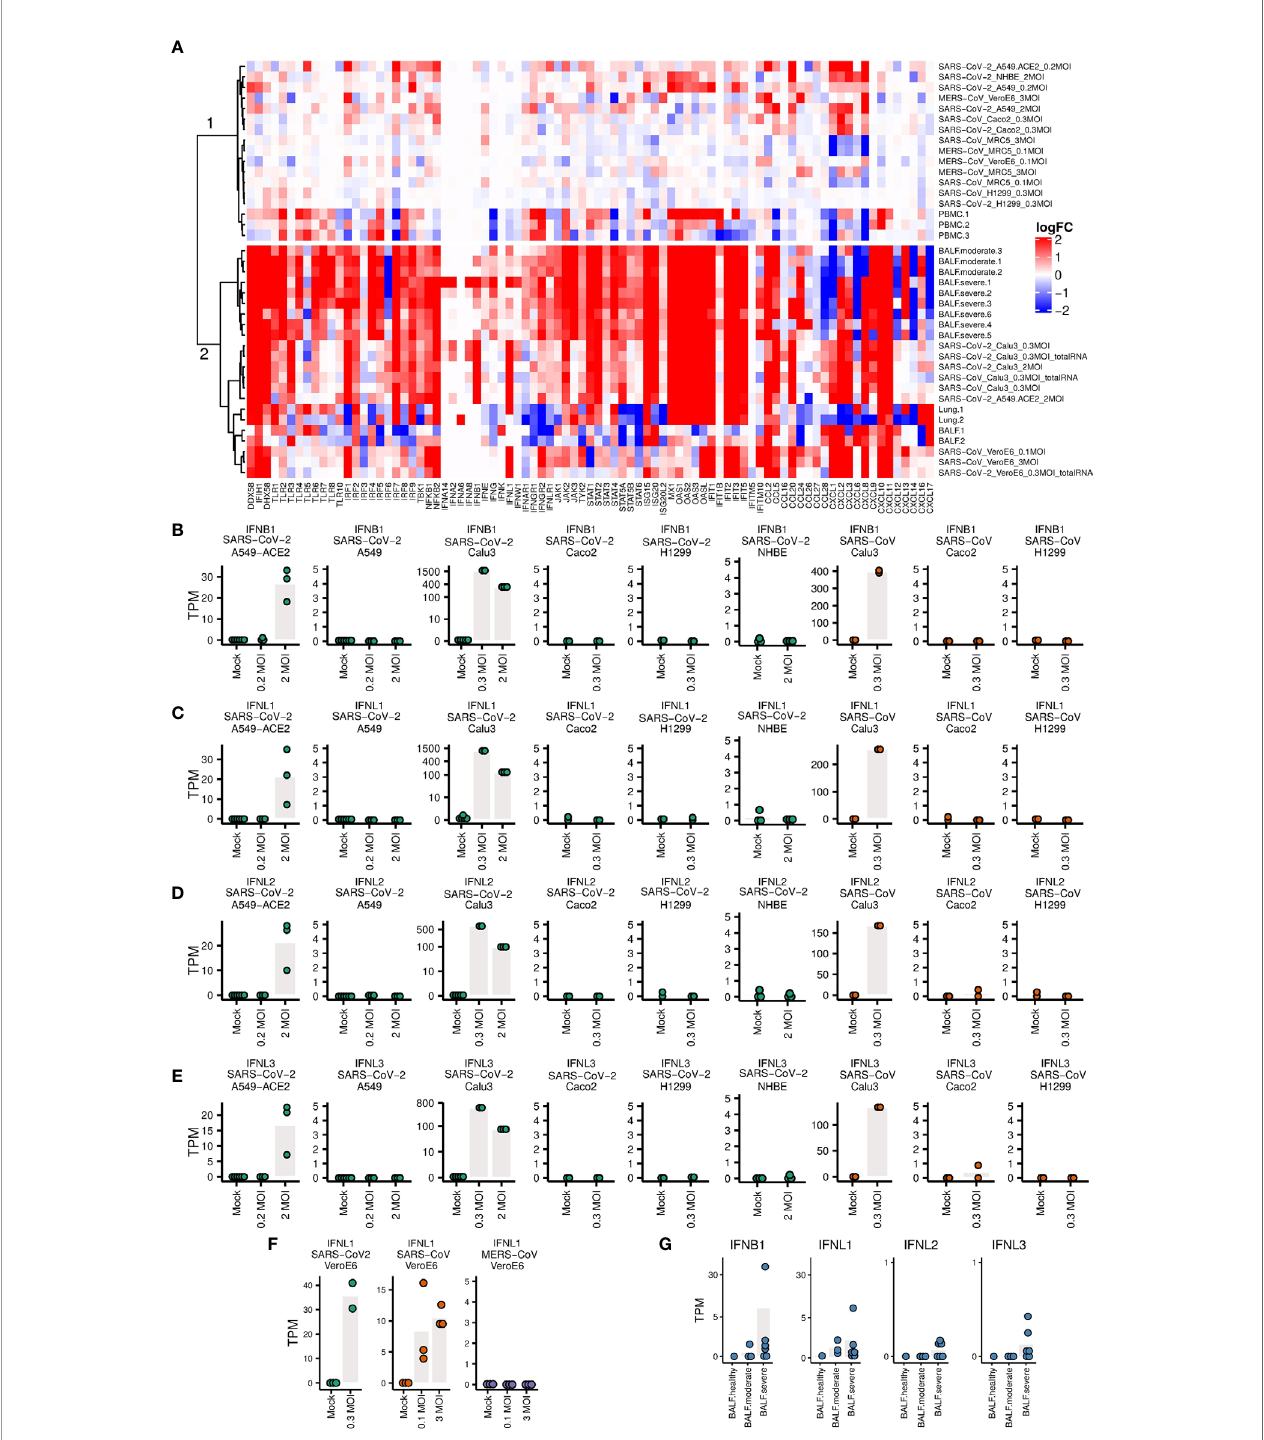
FIGURE 4 | Expression levels of genes related to immune responses (A) Heatmap of the logFC of IFNs, ISGs and pro-in fl ammatory cytokines. The clustering of samples produces a cluster 1 (top) with little IFN/ISG expression comprising MERS infections and non-infectable cells/SARS-CoV-1/2 (except for Caco2 cells), and a cluster 2 (bottom) strong IFN/ISG expression with SARS-CoV-1/2 infectable cells and patient samples. (B – G) Expression levels of IFNs. Each dot represents the expression value of a sample. Bars indicate mean expression levels (in TPM) of respective IFN at different MOI